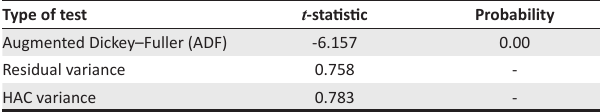
TABLE 3: Kao residual co-integration test. Type of test